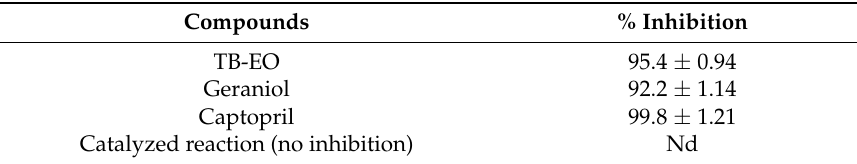
Table 5. In vitro ACE inhibitory activities of TB-EO, geraniol, and